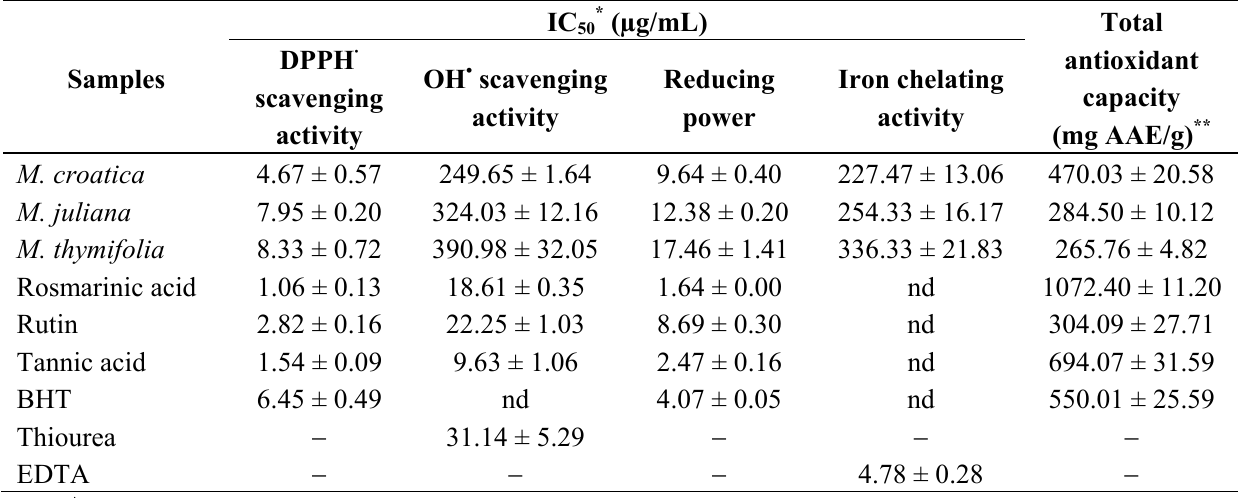
Table 2. Comparative overview of IC values as well as total antioxidant capacities of 50 Micromeria ethanolic extracts, polyphenolic compounds and reference antioxidants.